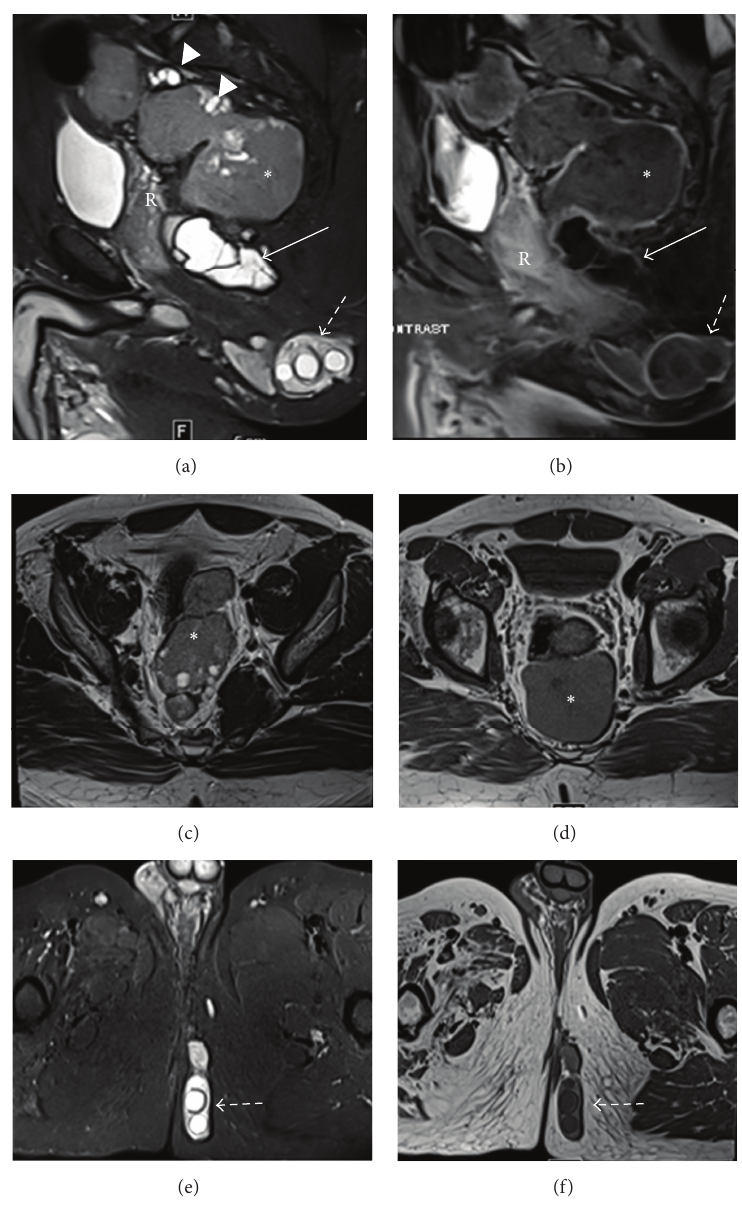
Figure 3: (a) Sagittal T2-weighted MR image with fat saturation shows a predominantly intermediate T2 signal intensity presacral/retrorectal multilocular lesion (asterisk) with multiple internal T2 bright foci and smaller peripheral cysts (arrowheads). Note the anterior displacement of the rectum. The left ischioanal (solid arrow) and subcutaneous perineal hydatid cysts (dashed arrow) show high T2 signal intensity with dark internal septations and rims. (b) Sagittal T1-weighted postcontrast MR image shows peripheral rim enhancement of the retrorectal tailgut cyst (asterisks) as well as the ischioanal (solid arrow) and perineal subcutaneous hydatid cysts (dashed arrow). ((c) and (d)) Axial T2-weighted (c) and T1-weighted (d) MR images show the retrorectal lesion of intermediate signal intensity (asterisk) with peripheral small cyst. ((e) and (f)) Axial T2-weighted (e) and T1-weighted (f) MR images show the left subcutaneous perineal hydatid cysts (dashed arrow) of high T2 signal intensity and intermediately low T1 signal intensity with internal daughter cysts and a dark